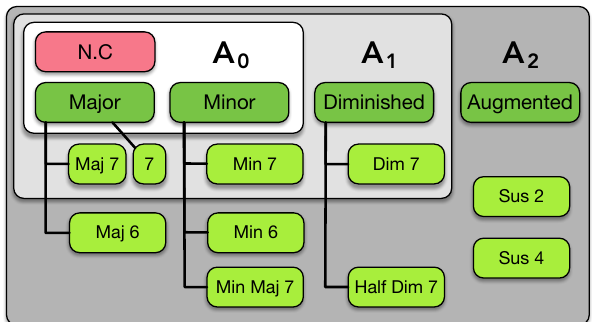
Figure 5. The three chord vocabularies A 0 , A 1 , and A 2 we use in the next chapters are defined as increasingly complex sets. The standard triads are shown in dark